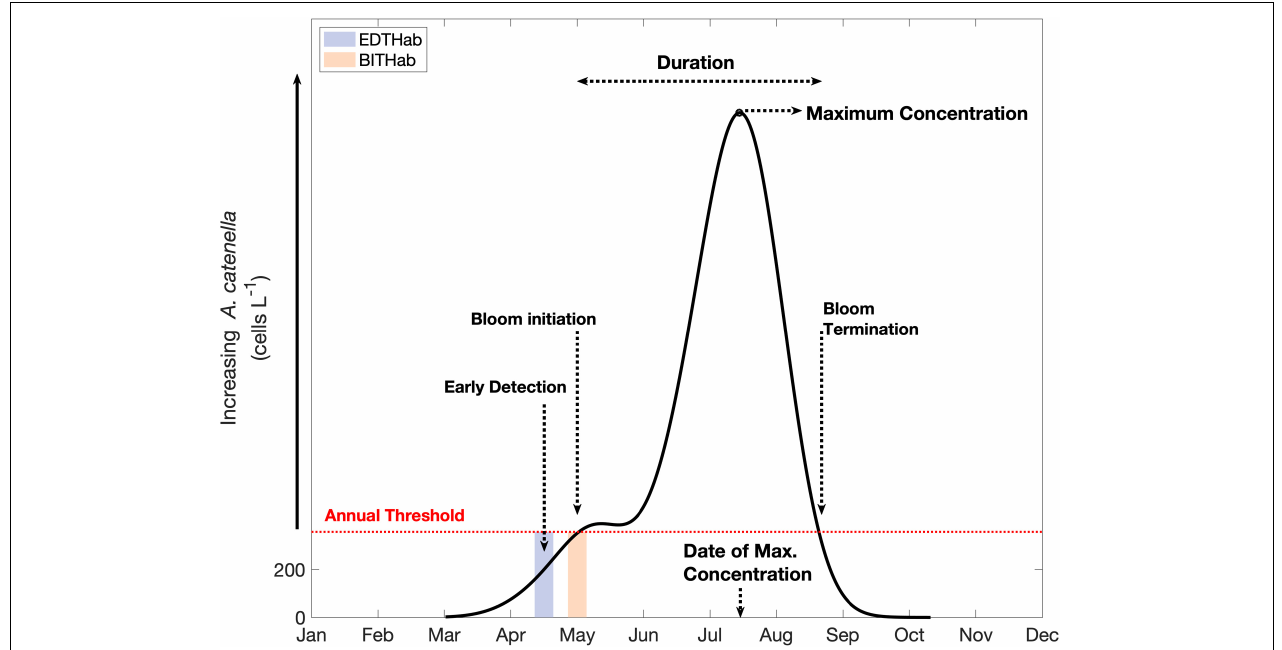
FIGURE 2 | Conceptual example for bloom metrics and thermal habitat determination for A. catenella . The continuous black line represents the hypothetical distribution of A. catenella concentrations over time; the red dashed line corresponds to the annually specific threshold (year median + 10%) and the colored boxes highlight the time window within which we gathered temperature data to characterize the thermal habitats (EDTHab and BITHab). Dashed arrows indicate different metrics of A. catenella blooms determined by the Threshold